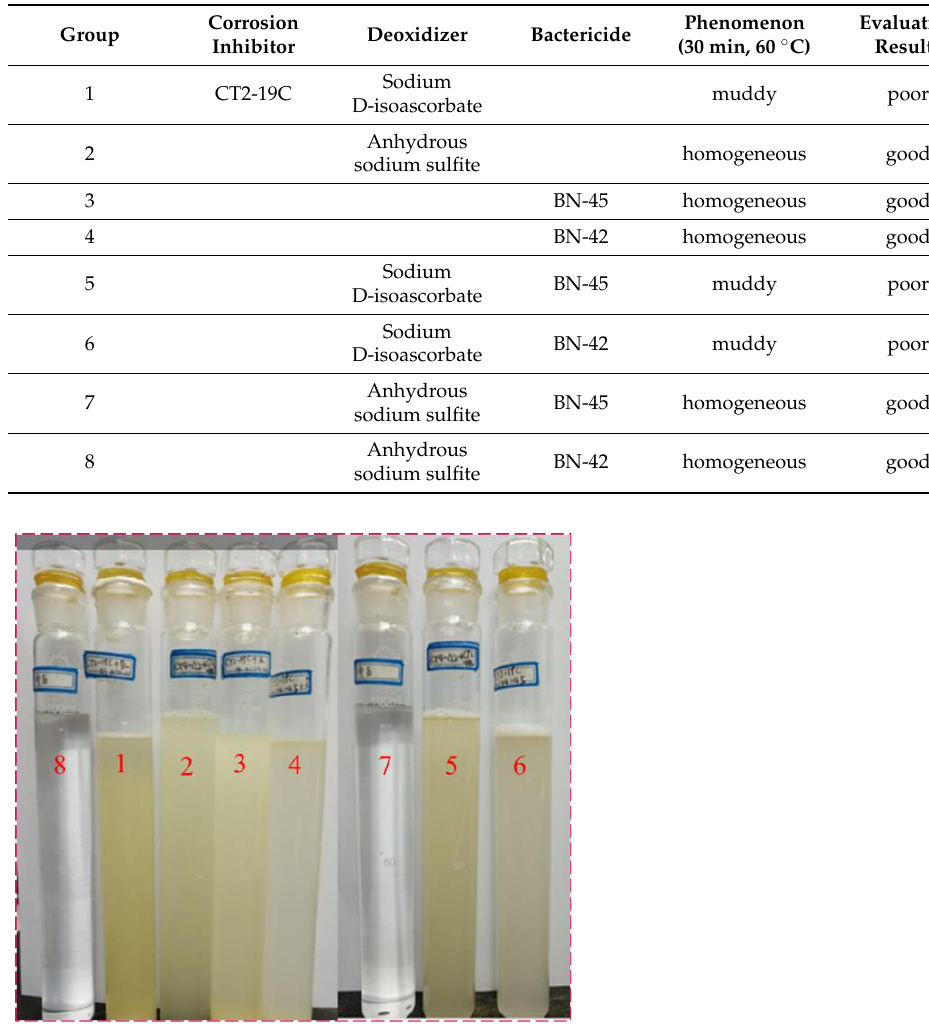
Figure 8. Compatibility of